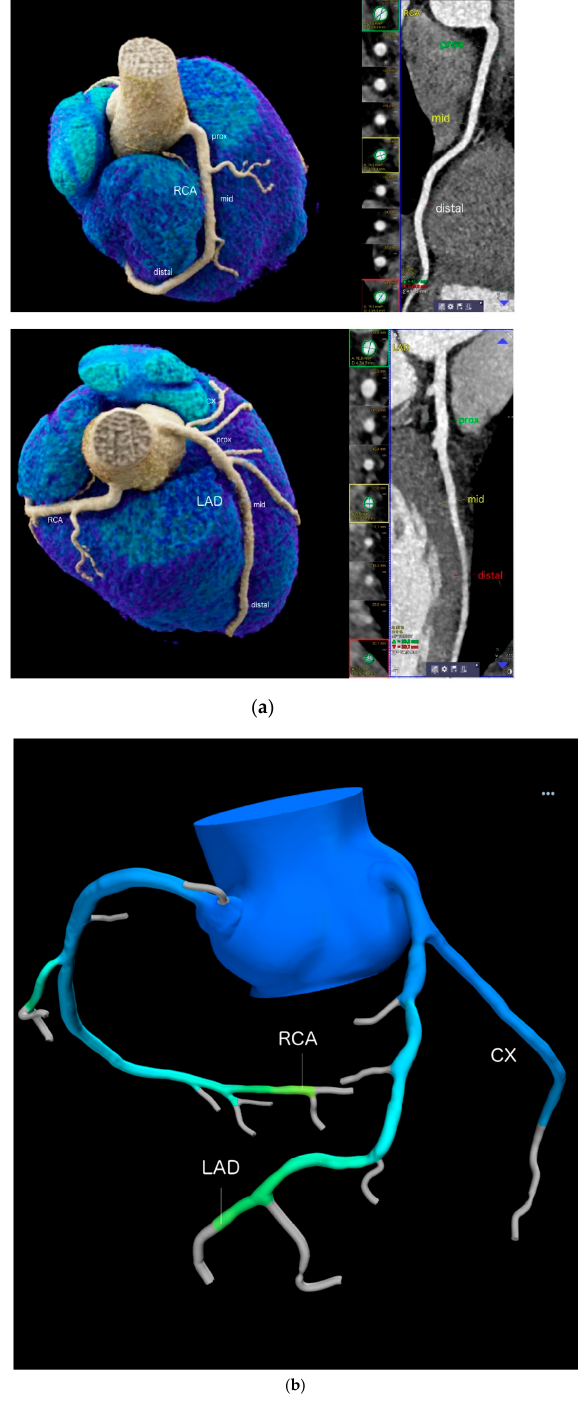
Figure 1. ( a ) 22-year-old professional male endurance athlete (swimmer) with regular high training volumes and a new onset of high-grade arrhythmia. Enlarged proximal but smaller mid and distal RCA (upper) and LAD (lower panel) segments (“ athlete’s artery ”). Quantitative CTA (right) included sizing of RCA and LAD dimensions at 3 sites (proximal, mid and distal) using curved multiplanar reformations (cMPR). Both vessel area (mm 2 ) and 2 diameters (mm) were taken. Left panels show volume rendering technique (VRT). CX = circumflex artery. ( b ) 3D Quantification of vessel volumes (mm 3 ) for the RCA, LAD and CX by using a computational fluid modelling (CFD) software (Heartflow, Inc. Redwood, CA, USA) in another patient.